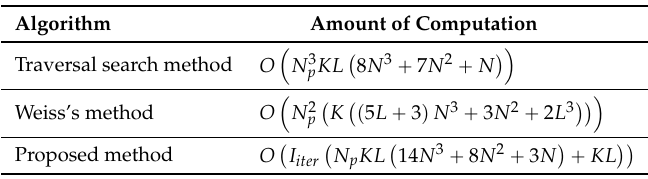
Table 2. Computational